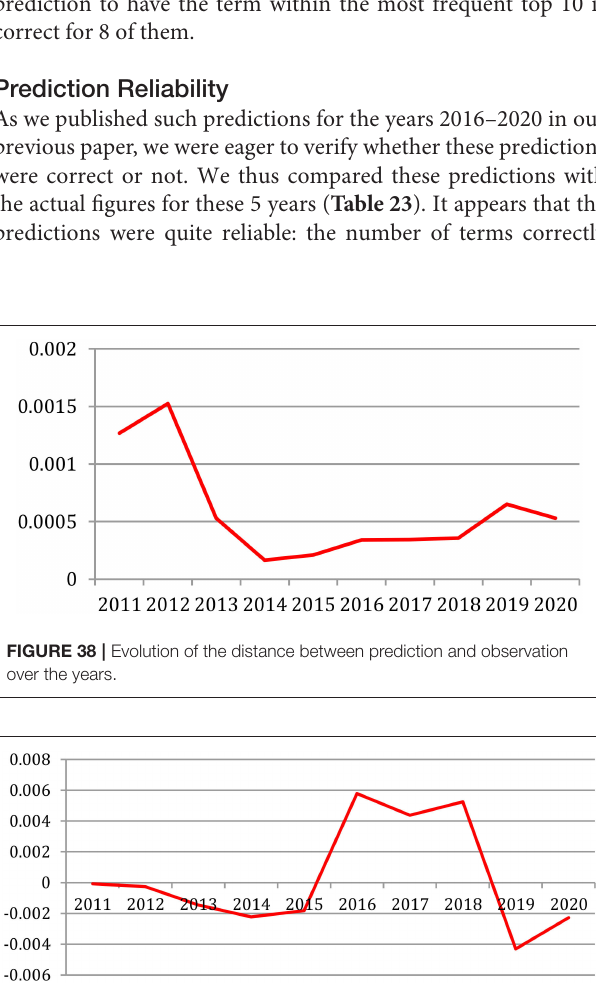
TABLE 24 | Predictions for the next 5 years (2021–2025).